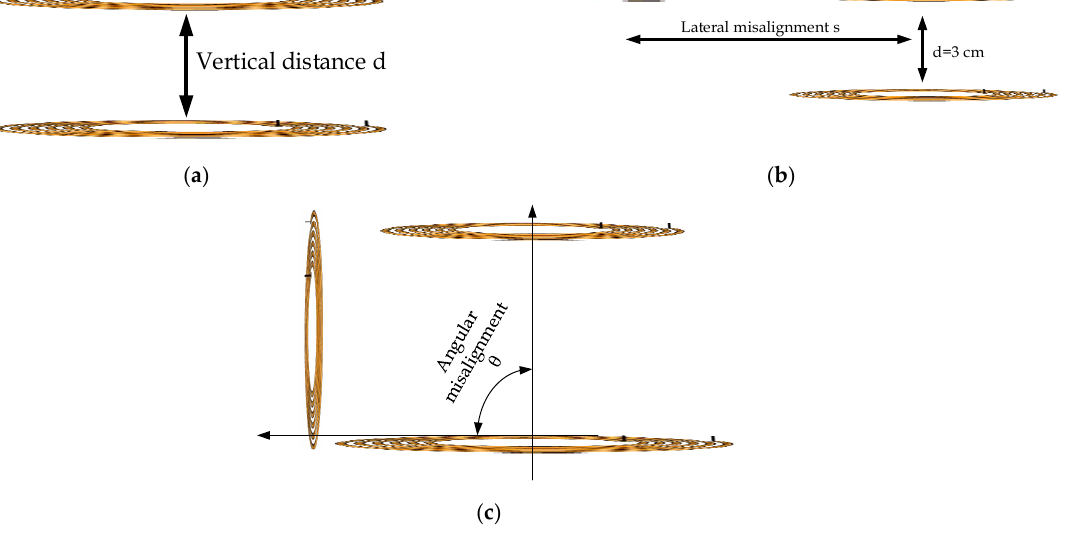
Figure 1. Misalignment scenario top view of Tx and Rx in a study of ( a ) the coil separation, ( b ) lateral misalignment, ( c ) receiver rotating around the transmitter.